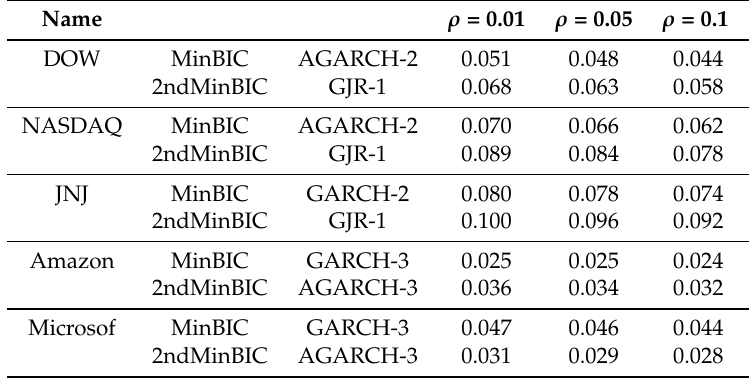
Table 13. The AS Performance Index for Multi-Period Gambles for the Stock Returns. Name ρ = 0.01 ρ = 0.05 ρ =